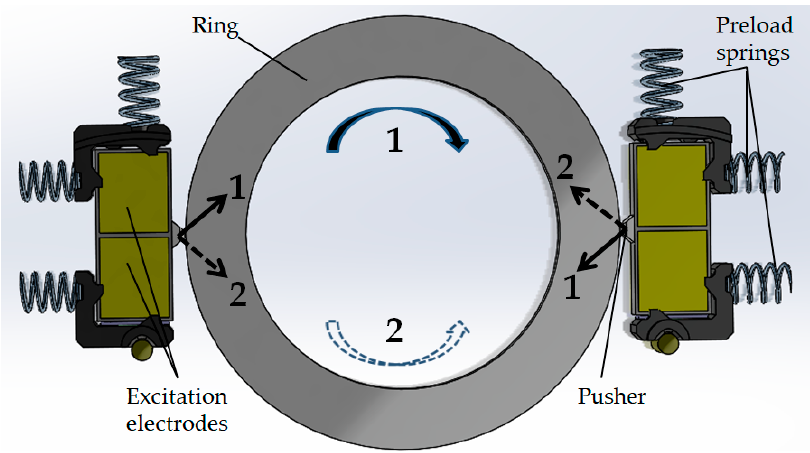
Figure 2. Actuation in PILine ® piezo rotary stage.